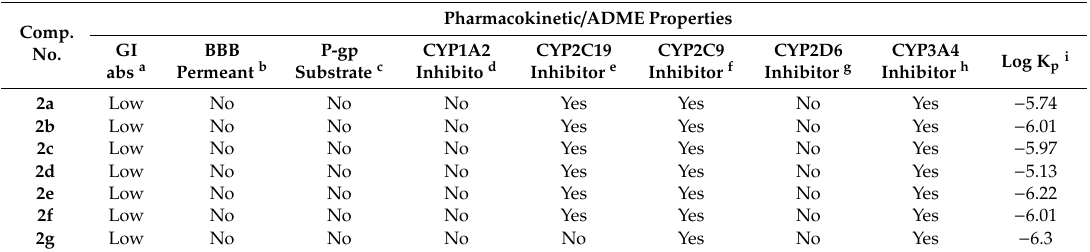
Table 3. Pharmacokinetic / ADME (absorption, distribution, metabolism, and excretion) properties of compounds 2a – 2g